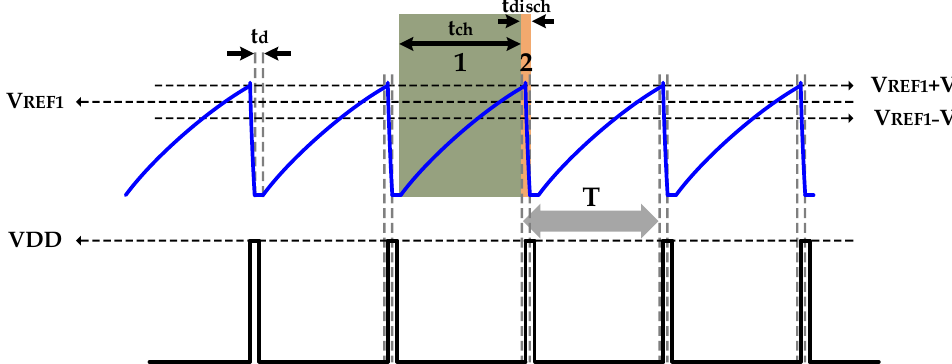
Figure 2. Timing diagram of the positive input (Node.1) and output of Comp.1.